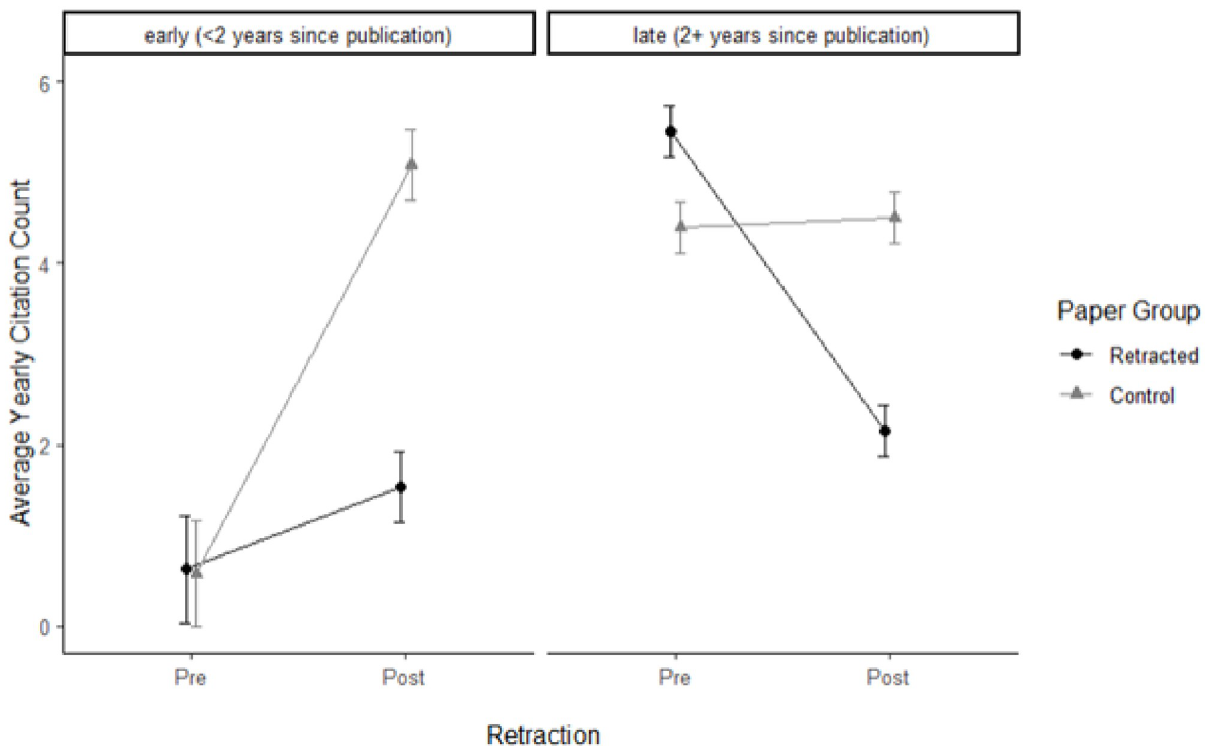
Fig 6. Retraction by time of publication, for papers immediately (early), and later retracted (late).